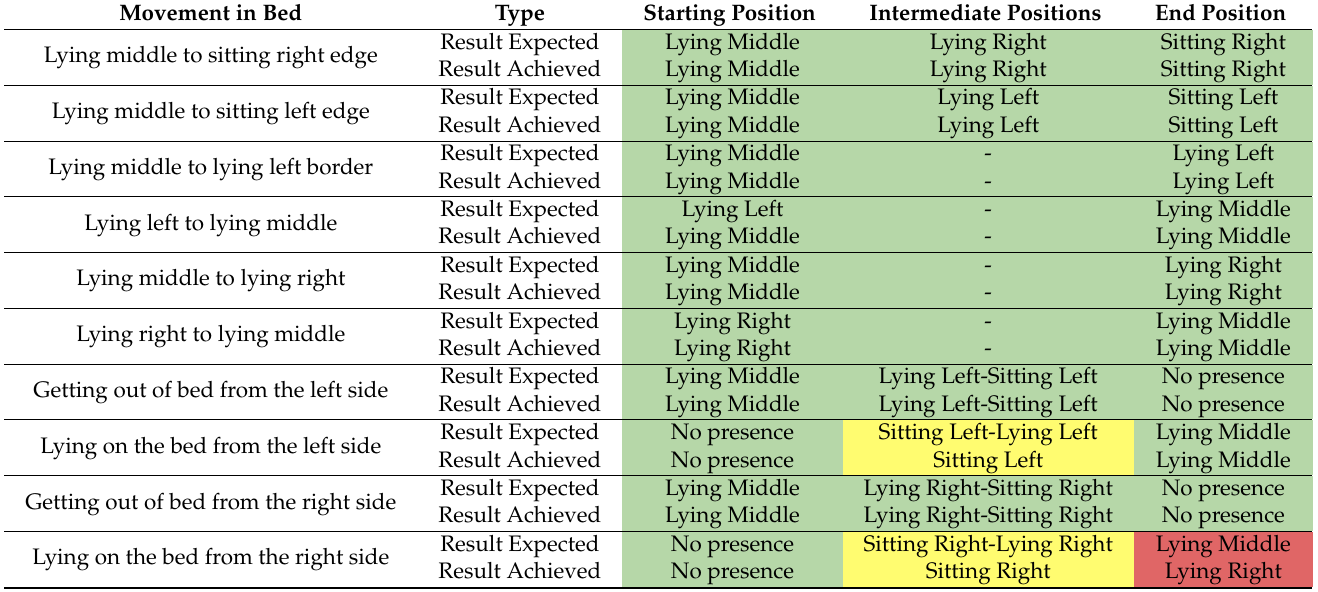
Table 3. Results for the first battery of tests.